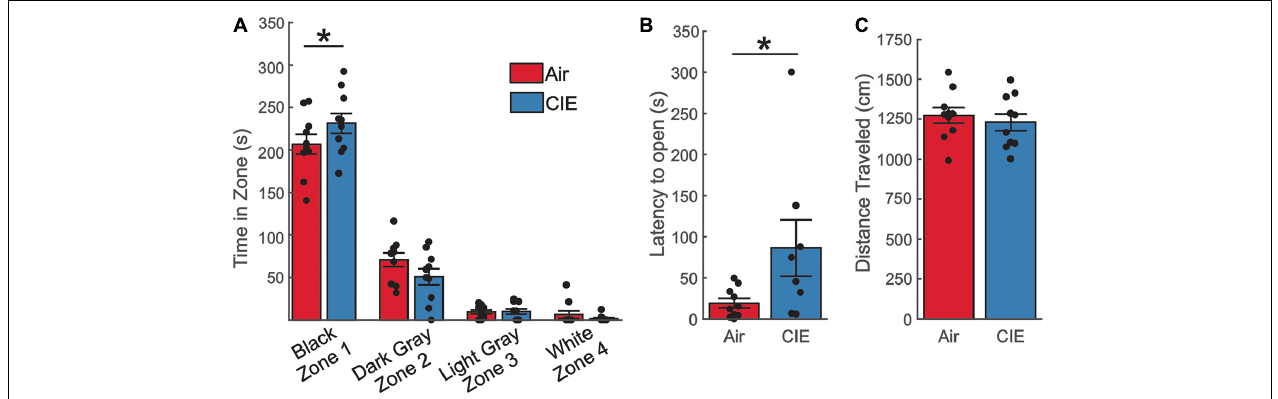
FIGURE 3 | The SAT revealed an anxiety-like phenotype in CIE-treated female rats. (A) CIE-treated female rats ( n = 10) spent more time in the least anxiogenic zone (Black) than Air control rats ( n = 10), but the two groups spent comparable amounts of time in all other zones. (B) CIE-treated rats had a longer latency to venture into the most anxiogenic open zone (White). (C) The total distance traveled was similar between Air and CIE-treated female rats. All data are expressed as the mean ± SEM, * p < 0.05.